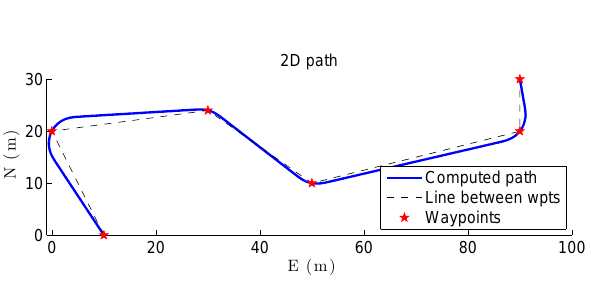
Figure 21: Dubins path with Fermat transition